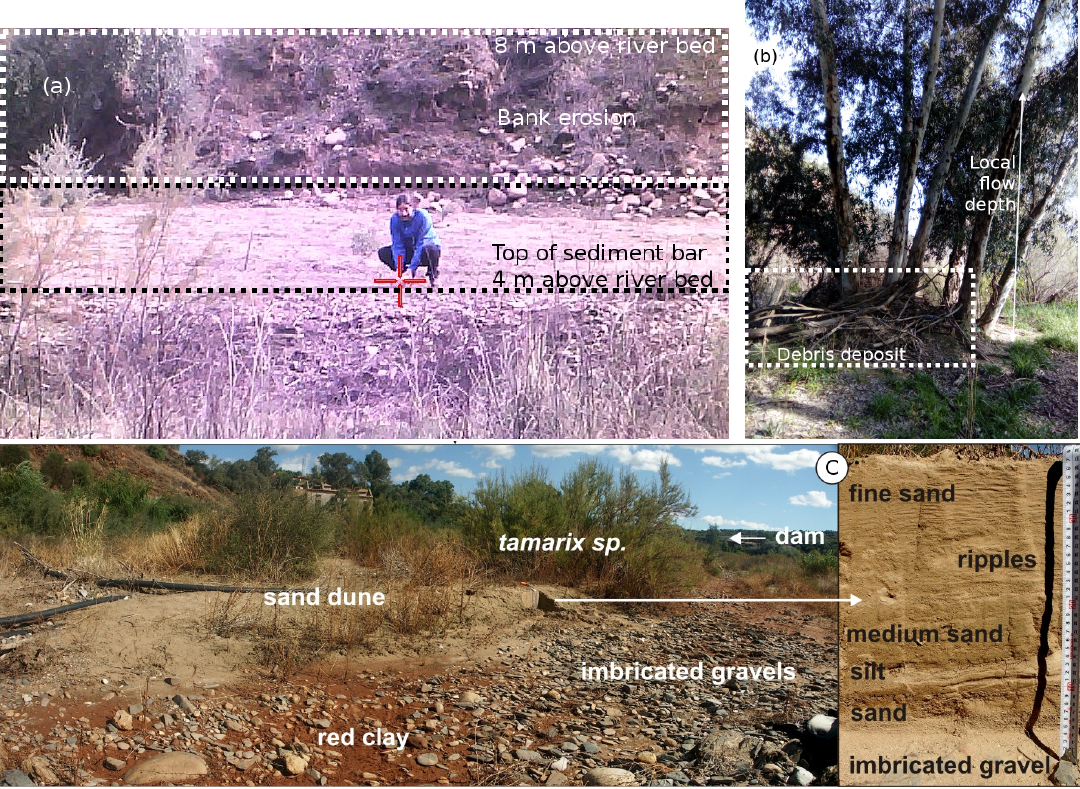
Figure 5. ( a ) Snapshot acquired with Leica DISTO TM S910 during the positioning of the top of the lateral bar in the river bend (square box in Figure 4a); ( b ) Botanical evidence in the left bank of the hydraulic control reach: it is located within the contraction area depicted in Figure 4a. The highest watermark in the tree (8 m above the thalweg) was used as botanical evidence establishing the water level of ∼ 180 m at x = 5100 m; ( c ) Sand dune downstream a tamarisk tree and sedimentological sequence of the internal organisation of the sand